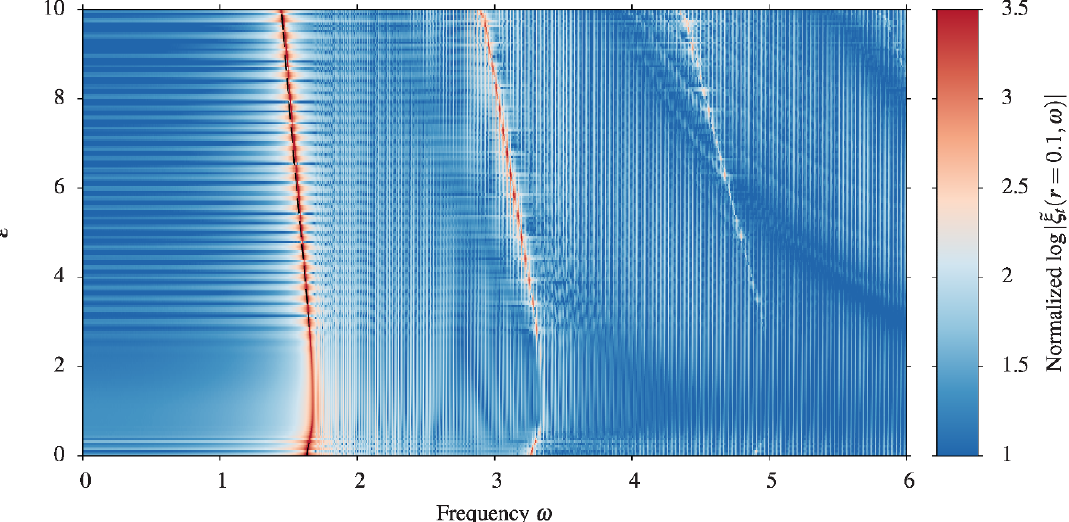
Figure 15 . FFT scan of the full dynamics for the full Skyrme model and m = 1 : 65. A window where the (cid:12)rst oscillating mode is replaced by a resonance is visible. The dashed line is the oscillating